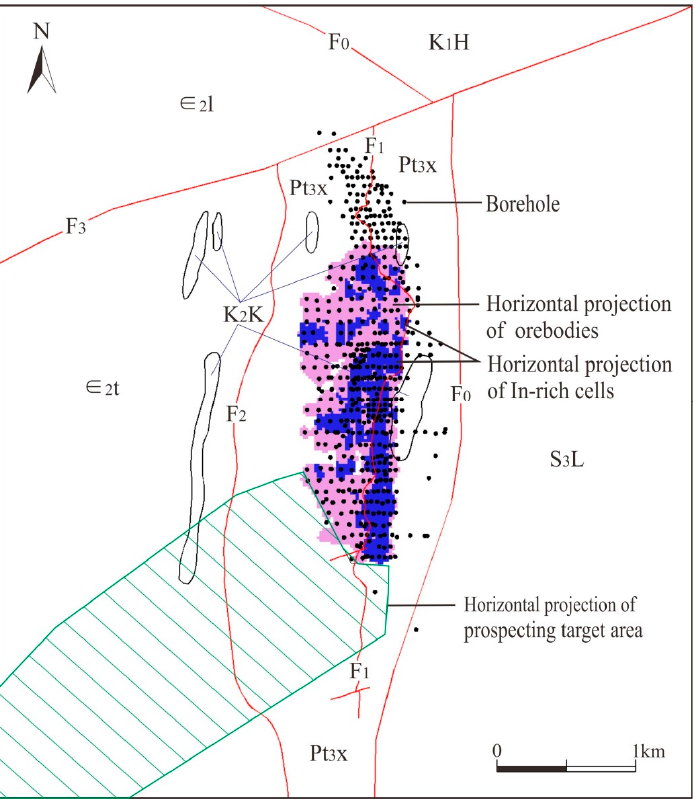
Figure 9. Metallogenic prediction map of indium-rich ore bodies. ∈ 2 l—Middle Cambrian Longha formation; ∈ 2 t—Middle Cambrian Tianpeng formation; Pt 3 x—Neoproterozoic Xinzhai formation; K 1 H—Cretaceous granite; K 2 K—Cretaceous granite porphyry; S 3 L—Silurian granite. K 1 H—Cretaceous granite; K 2 K—Cretaceous granite porphyry; S 3 L—Silurian